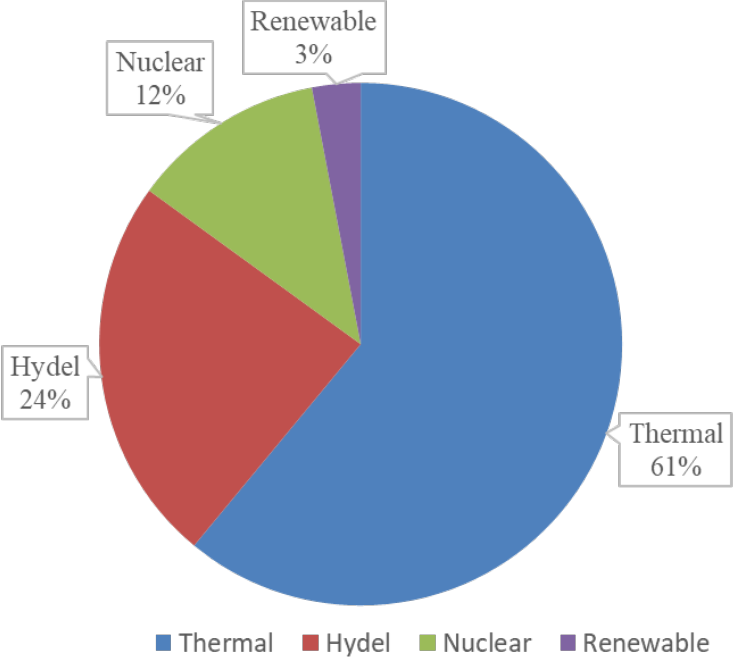
Figure 1. Pakistan’s Sources Share in Electricity Generation during 2021–22 [1,54].